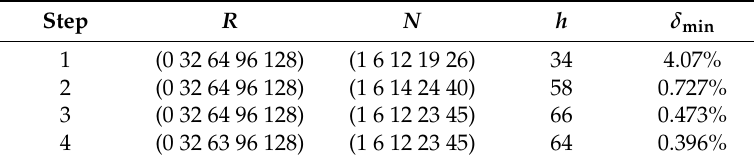
RSD minimum δ min of the effective irradiance density obtained in each design